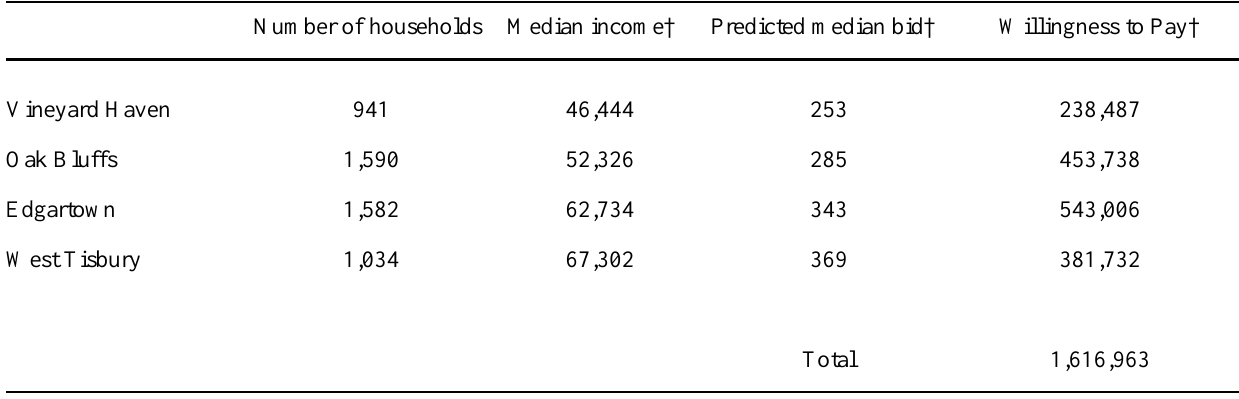
Table 2. Number of households and median income used to model willingness to pay for access to recreational shellfisheries in Lagoon Pond, Martha’s